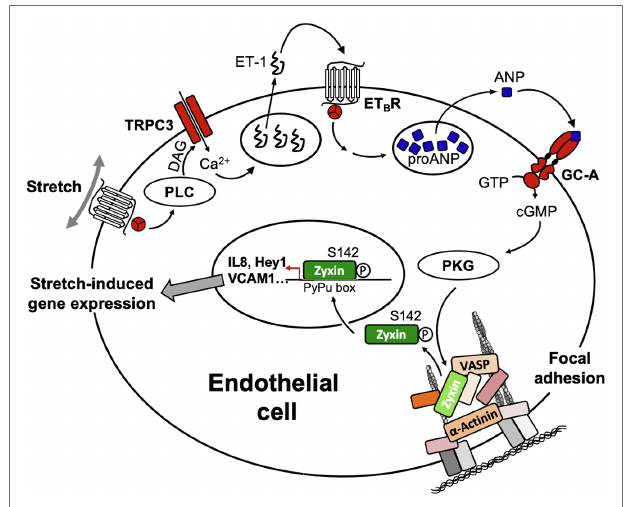
FIGURE 7 | Scheme of the signal transduction cascade in EC ultimately leading to translocation of zyxin from FA to the nucleus. ANP, atrial natriuretic peptide; DAG, diacylglycerol; ET-1, endothelin-1; ET B R, B-type endothelin-1 receptor; GC-A, A-type guanylyl cyclase receptor; PLC, phospholipase C; PKG, protein kinase G; TRPC3, transient receptor potential cation channel subfamily C member 3; VASP, vasodilator-stimulated